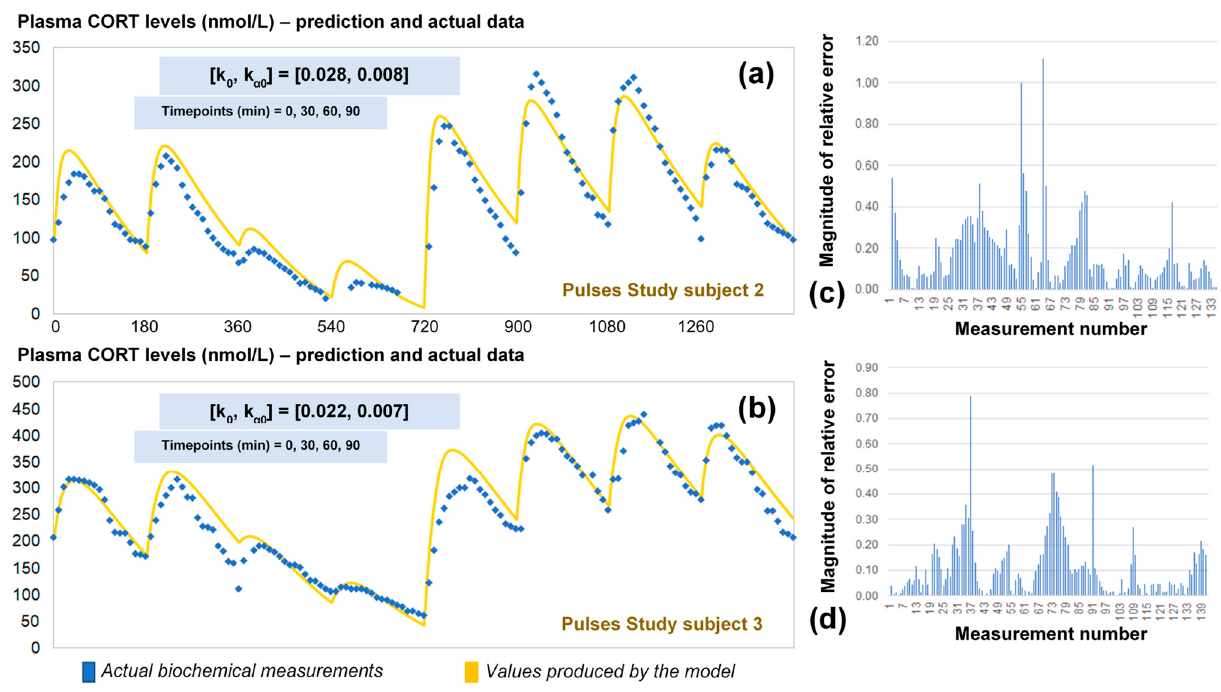
Figure 4. Assuming discretely varying absorption and clearance rates (revised model), the brute- force search method provides the initial pair of (k 0 , k α 0 ), based on four CORT measurements (e.g., at time points 0, 30, 60 and 90 min), and subsequently estimates the whole 24-h profile of plasma cortisol. The data from the Pulses study Subject 1 was used (see Materials and Methods). CORT: cortisol, k: clearance rate, k α : absorption rate. Time points of delivery (magnitude of doses): 0 min